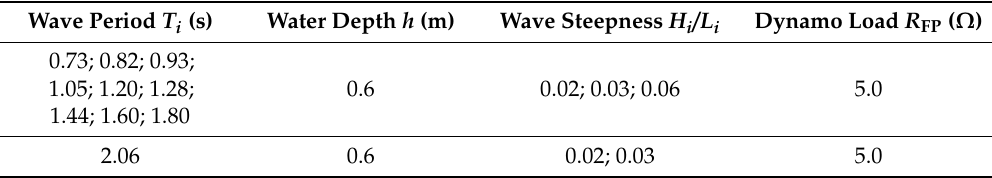
Table 1. Cases of experiment series A.